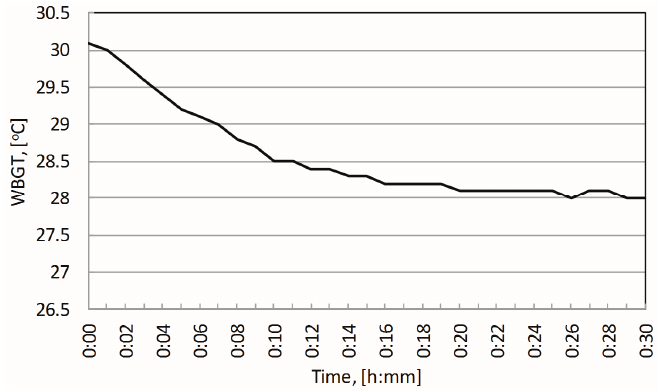
Figure 11. E ff ect of the opaque drape on the WBGT index. Figure 11. Effect of the opaque drape on the WBGT index. Figure 11. Effect of the opaque drape on the WBGT index. Figure 11. Effect of the opaque drape on the WBGT index.